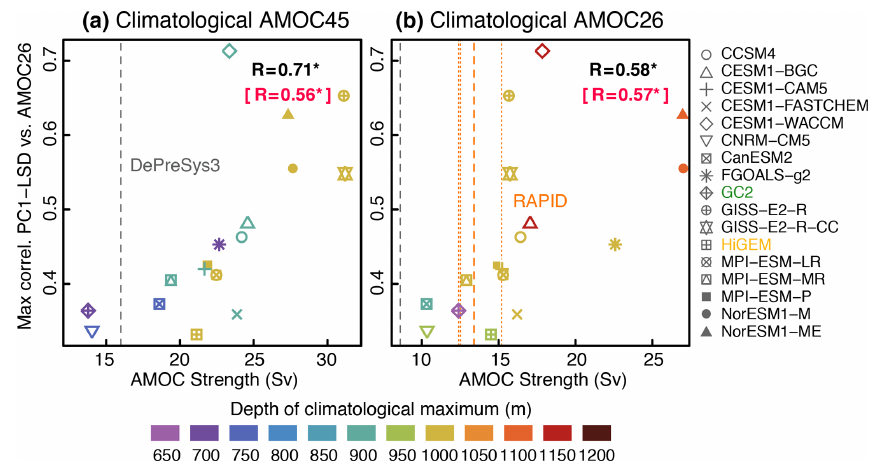
Figure 8. (a, b) Scatterplot of the maximum cross-correlation value in Fig. 4b between PC1-LSD and AMOC26 against the climatologi- cal AMOC45 and AMOC26 means, respectively. All AMOC indices refer to the values after the Ekman transport signal is removed. The maximum correlations are based on 10-year running trends and always happen when PC1-LSD leads the AMOC26 index. Colours indicate the depth at which the climatological AMOC maximum occurs. The correlation coefficient between the maximum PC1-LSD correlation and the climatological mean AMOC is shown in the top left corner in black. The analogous correlation but against the depth of the mean clima- tological AMOC is shown in magenta. The presence of an asterisk indicates that the correlation is significant at the 95% confidence level. The dashed grey vertical lines mark the climatological AMOC strength value in the DePreSys3 assimilation run. The orange vertical lines indicate the climatological value from RAPID observations (Smeed et al., 2018) from 2004 to 2016 (dashed) and in three non-overlapping sub-periods of 4 years